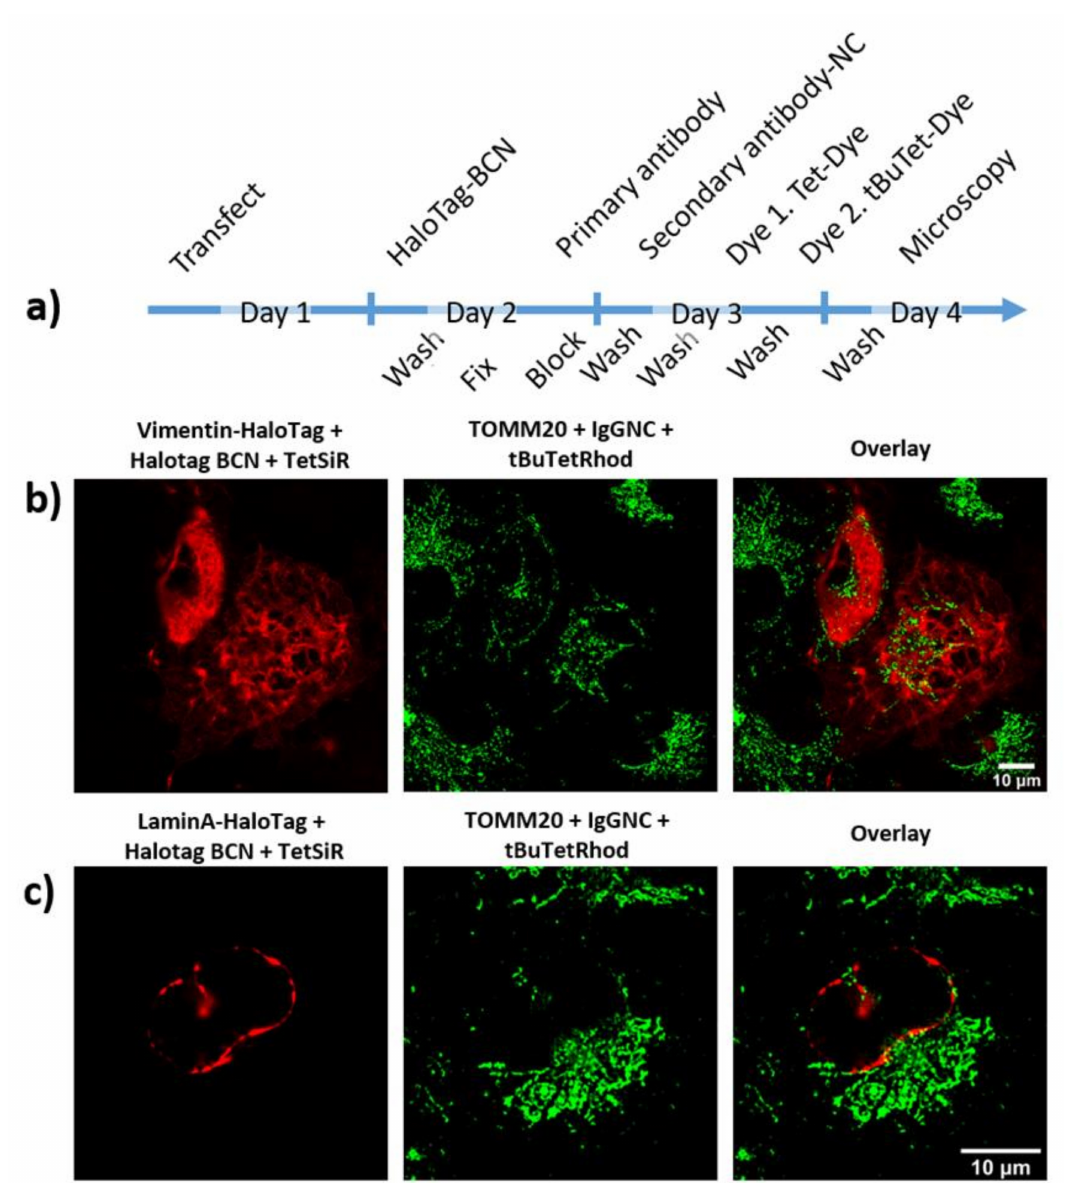
Figure 5. ( a ) Chart representing the workflow for fixed-cell dual-colour bioorthogonal labeling inside COS-7 cells expressing a HaloTag fused POI. Cells were fixed after the reaction with HaloTag ligand- BCN and labeled with Tet-SiR in parallel with immunofluorescent labeling of mitochondria using anti-TOMM20 primary antibody and IgGNC ( a ) secondary antibody activated with NHS-isonitrile ( NHS-NC , 23 )—followed by the cycloaddition of tertbutyl-tetrazine conjugated rhodamine ( tBuTetRhod ). ( b , c ) Confocal images of dual colour fixed cell labeling using the strategy described in ( a ). ( b ) COS-7 cells expressing Vimentin-HaloTag construct; double labeled through the described fixed-cell labeling strategy. ( c ) COS-7 cells expressing LaminA-HaloTag; also double-labeled as described in ( a ). Detection windows: red channel (rhodamine) 565–615 nm; far red channel ( SiR ) 675–800 nm. False colours: Red: Tet-SiR labeling of HaloTag + HaloTag ligand-BCN tagged nuclear proteins. Green: Labeling of TOMM20 with rhodamine by cycloaddition between isonitrile/tertbutyl-tetrazine groups. Scale bar = 10 µ